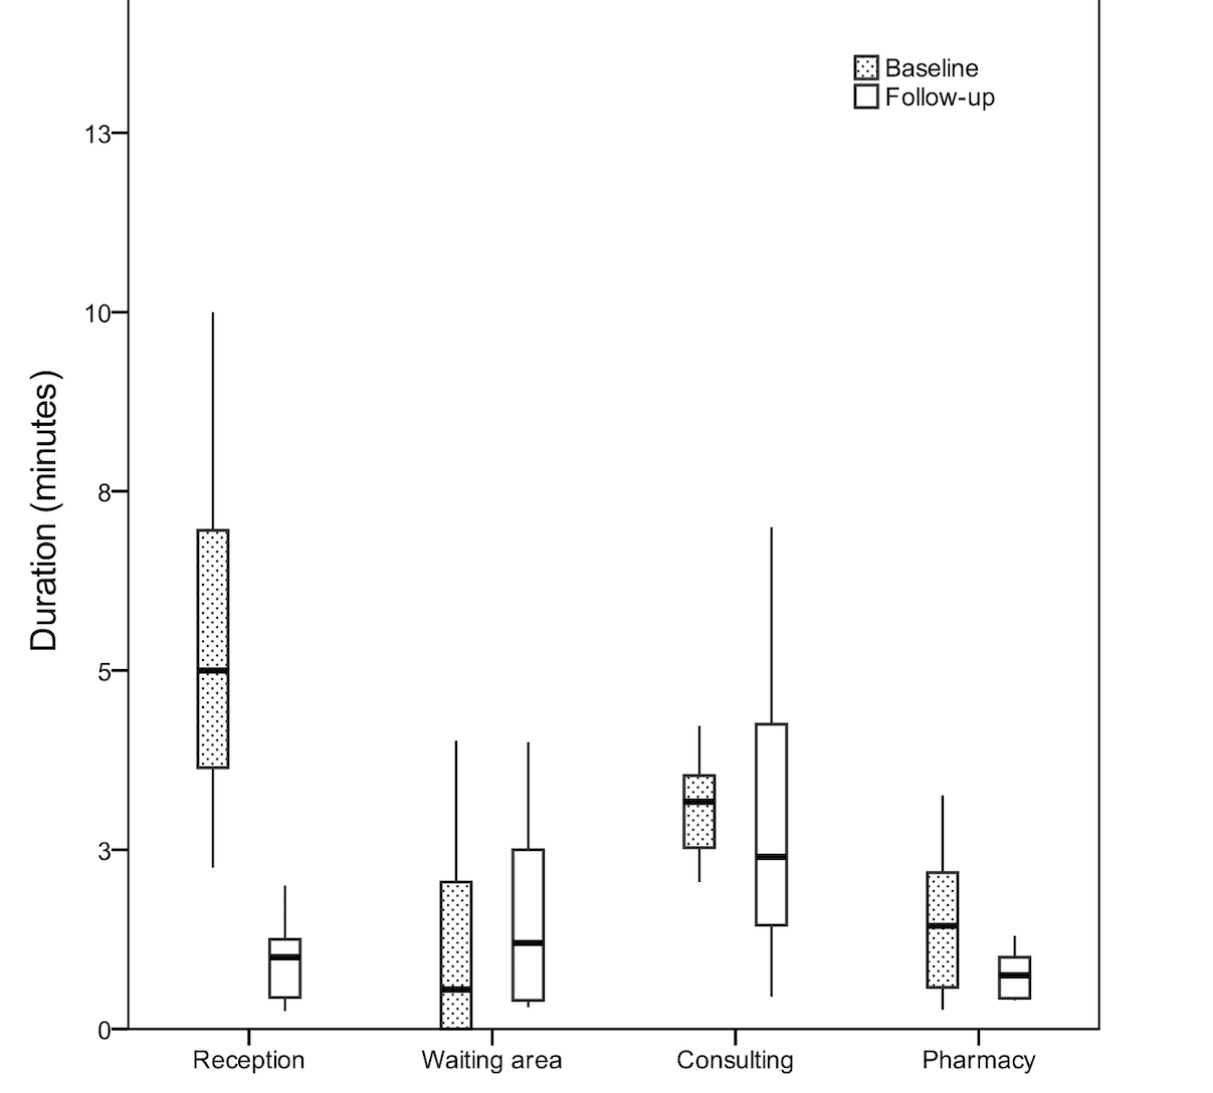
P valueRuralMetropolitanTask